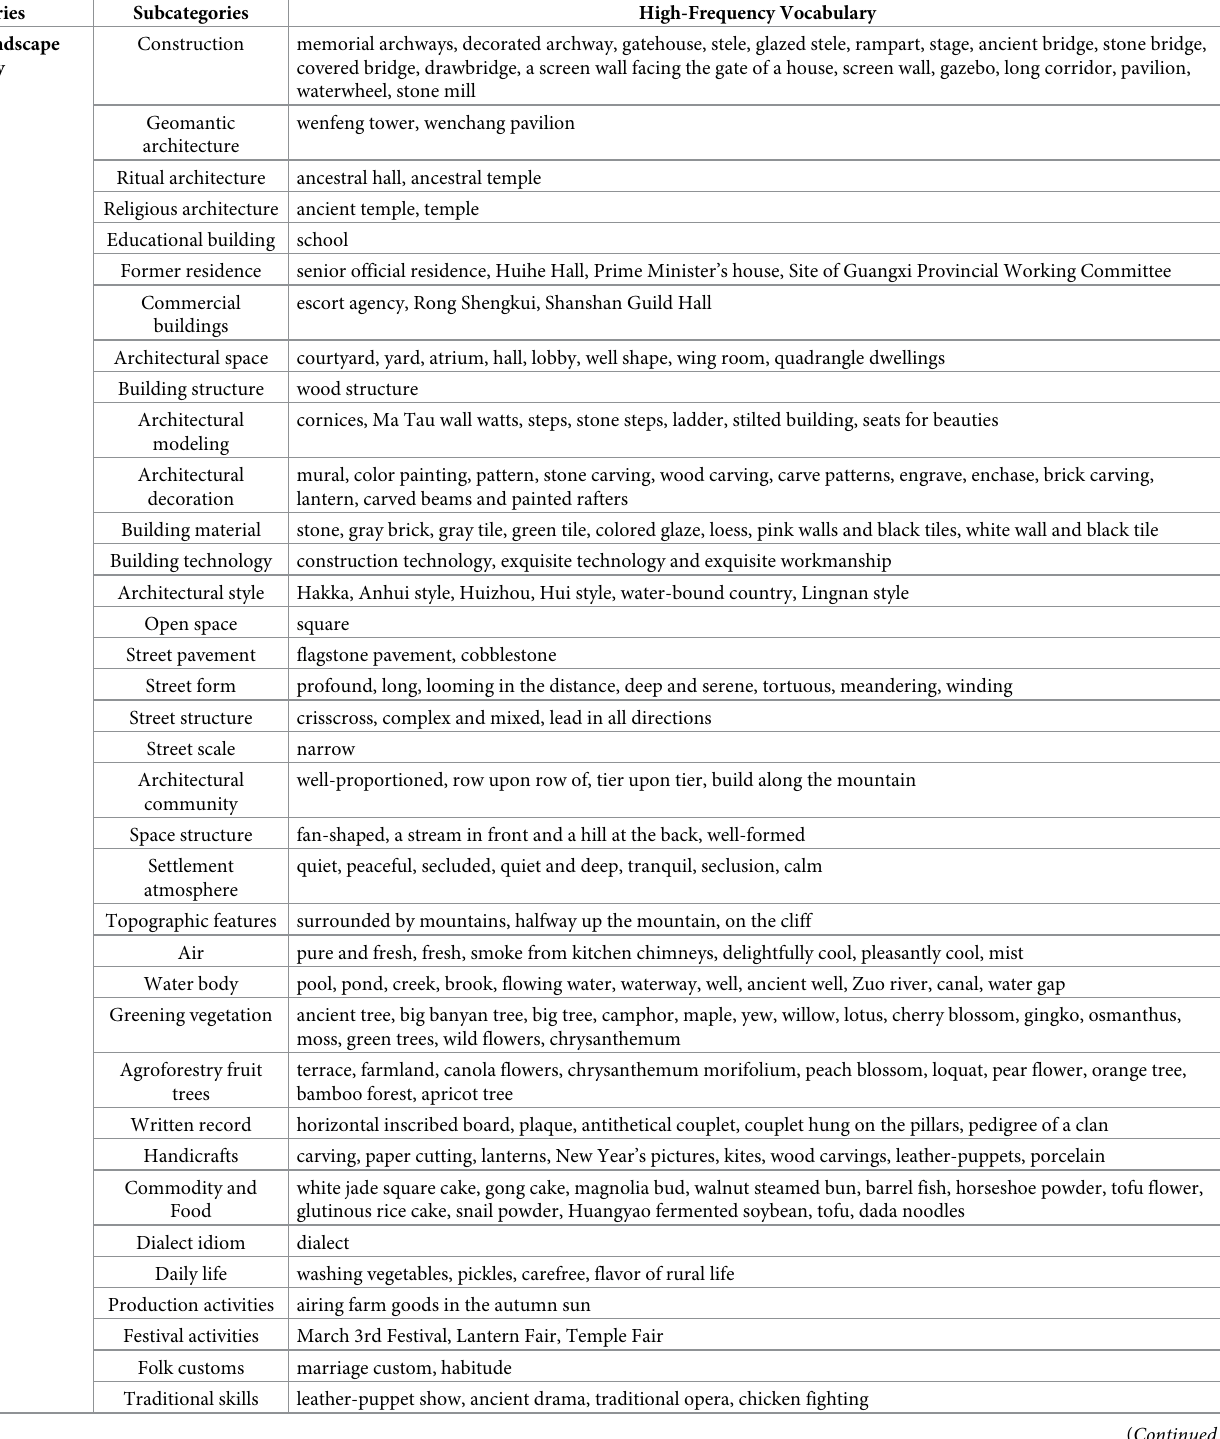
Table 4. Element system of cultural landscape perception in traditional settlements.